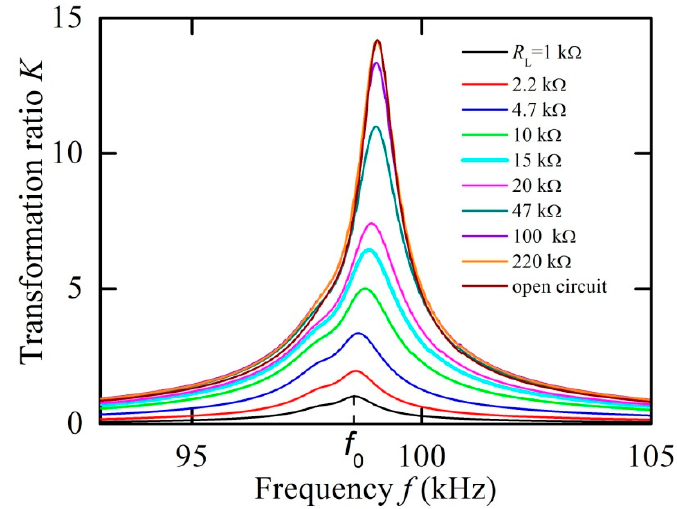
Figure 5. Frequency dependences of the transformation ratio K for different load resistances R L (1–220 k Ω ) at H m = 6.37 kA/m, which has been determined under open-circuit condition.